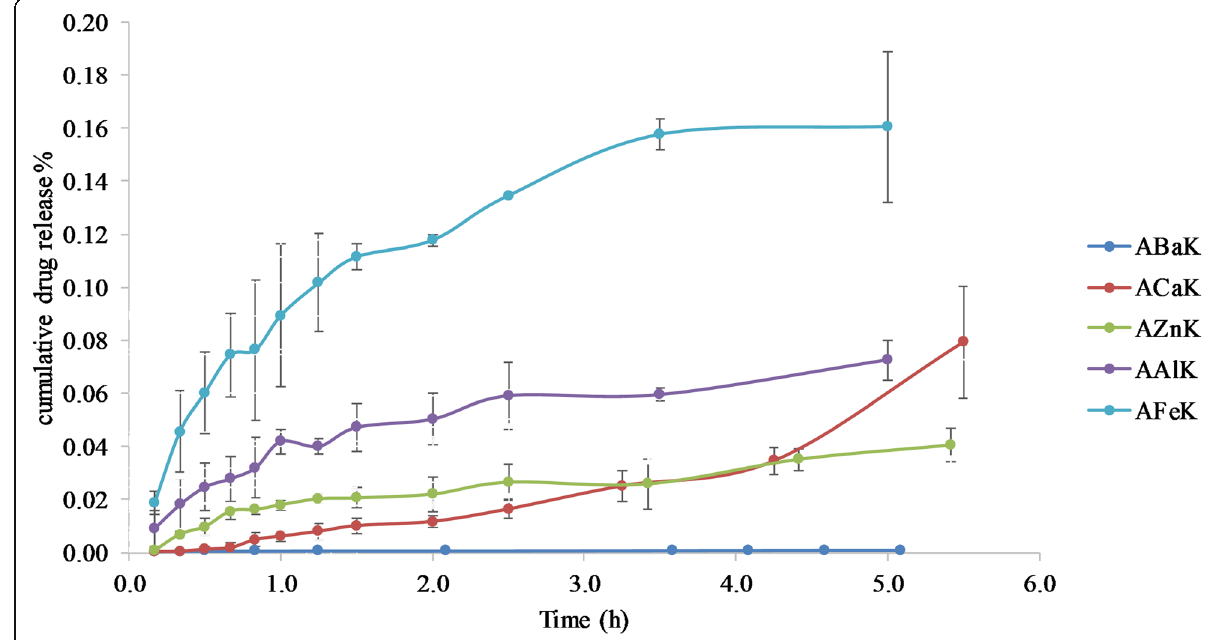
Fig. 2 Cumulative drug released KTP percentage curves for the studied